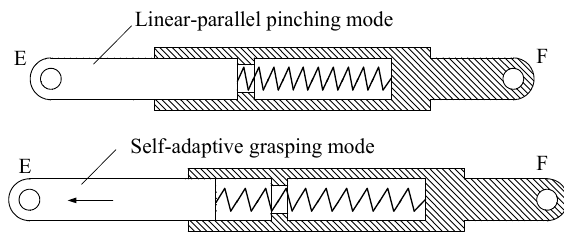
Figure 3. The length of the elastic component under different situations.